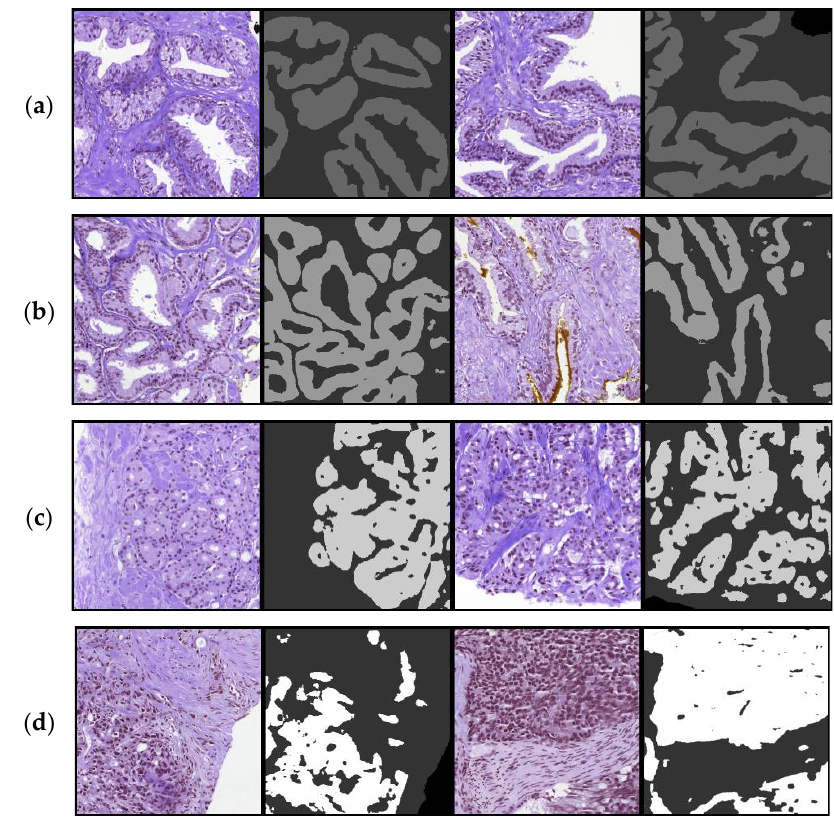
Figure 3. Sample selection of PANDA Radboud patches using the fixed-box technique paired alongside corresponding mask layer (on the right): ( a ) two samples of benign, ( b ) two samples of GS3, ( c ) two samples of GS4 and ( d ) two samples of GS5.